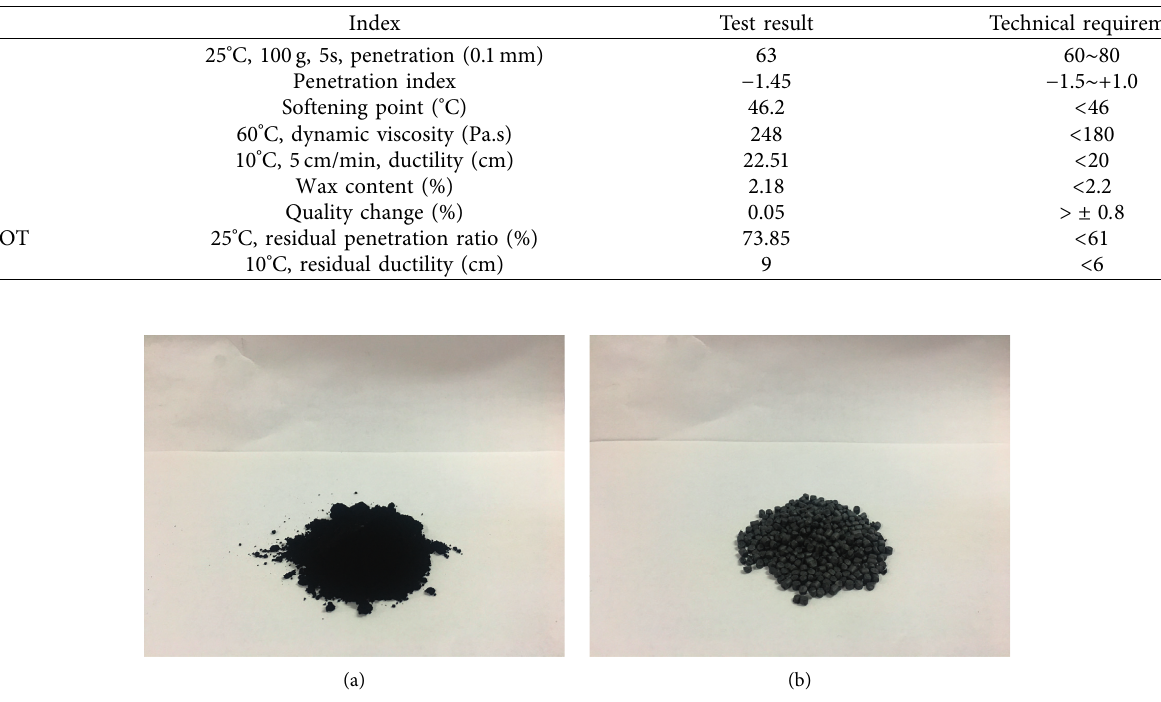
Table 1: Technical characteristics of A70# asphalt binders.